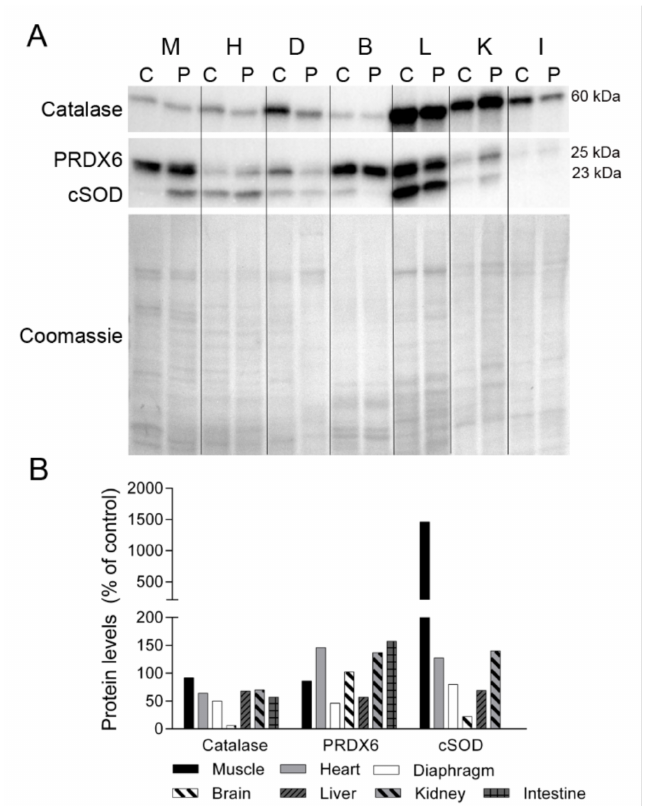
Figure 6. Antioxidant enzymes. ( A ) Representative Western blotting of antioxidant enzymes in tissue homogenates of a control (C) (n = 1) and the patient (P). Shown below is a representative Coomassie blue-stained gel. ( B ) Densitometry analysis: protein levels were normalized to total protein loading according to Coomassie blue staining. Data are expressed as percentage of control values. Abbreviations: M, skeletal muscle; H, heart; D, diaphragm; B, brain; L, liver; K, kidney; I, small intestine. PRDX6, peroxiredoxin 6; cSOD, cytosolic superoxide